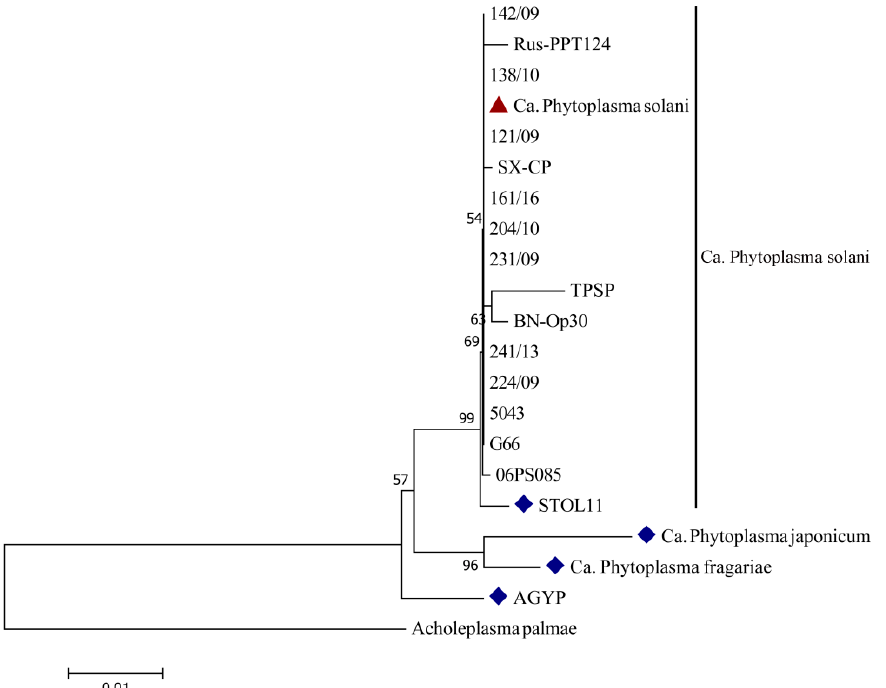
Figure 3. Neighbor-joining phylogenetic tree constructed with tested Serbian Ca. Phytoplasma solani strain from carrot and other Ca. Phytoplasma (solani, australiense, japonicum, and fragariae) strains from the NCBI database. Serbian Ca. The Phytoplasma solani strain from this study is marked with a triangle, and strains marked with a rhombus are reference strains for certain species.